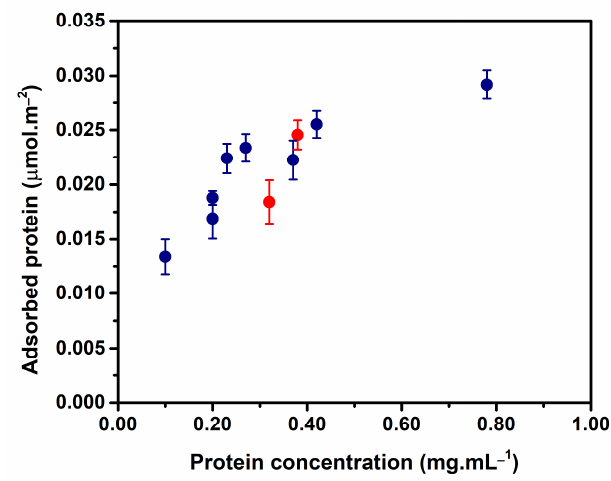
Figure 5. Isotherm of adsorption: amount of protein adsorbed as a function of the concentration of protein of the solution in equilibrium with the oxide support at 30 °C. The red symbols correspond to the addition of 2.5 mL and 5.0 mL of a glycerol–sorbitol mixture to the protein solution.